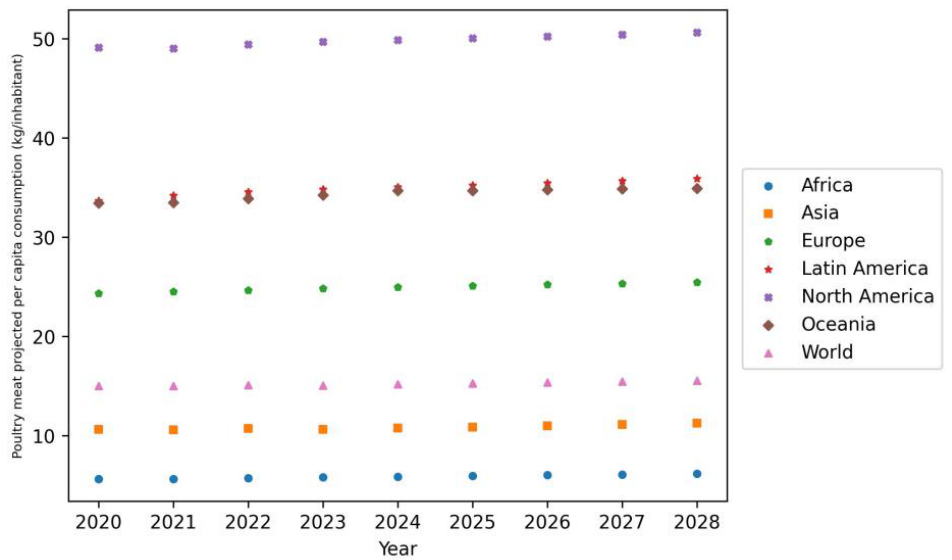
Figure 2. Poultry meat projected per capita consumption in the 2020–2029 period. Source: OECD (2023), Meat consumption (indicator). https://doi.org/10.1787/fa290fd0-en (accessed on 10 January